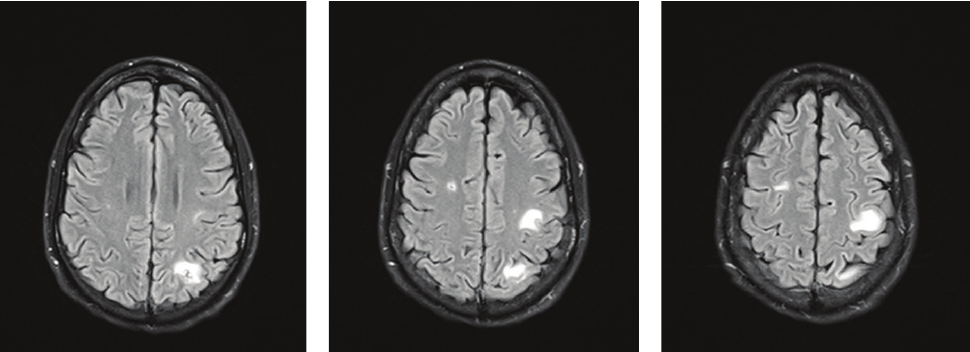
Figure 5: MRI of the brain revealing new interval hemorrhagic and nonhemorrhagic metastases within the bilateral parietal lobes and left occipital lobe visible on T2 FLAIR. This was found after starting chemotherapy with 4 cycles of bleomycin, etoposide, and